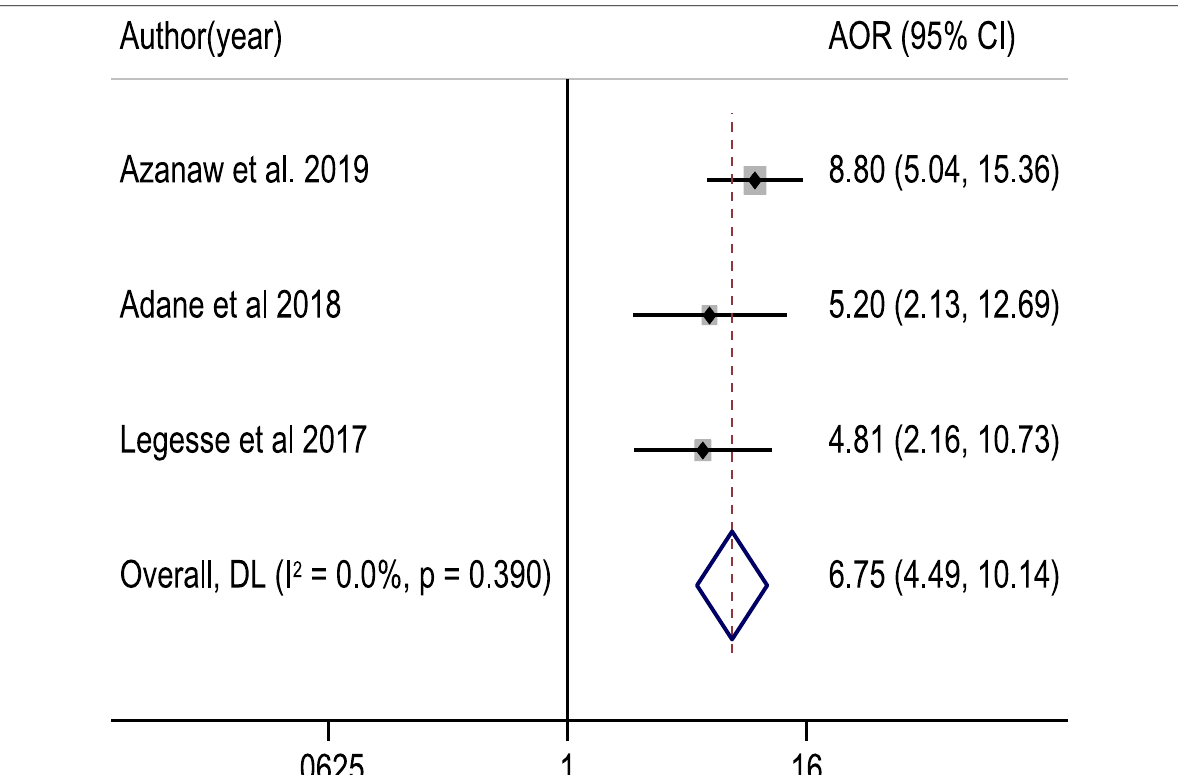
Fig. 8 The pooled adjusted odds ratio of the association between routine medical checkup of food handlers and food hygiene practice in